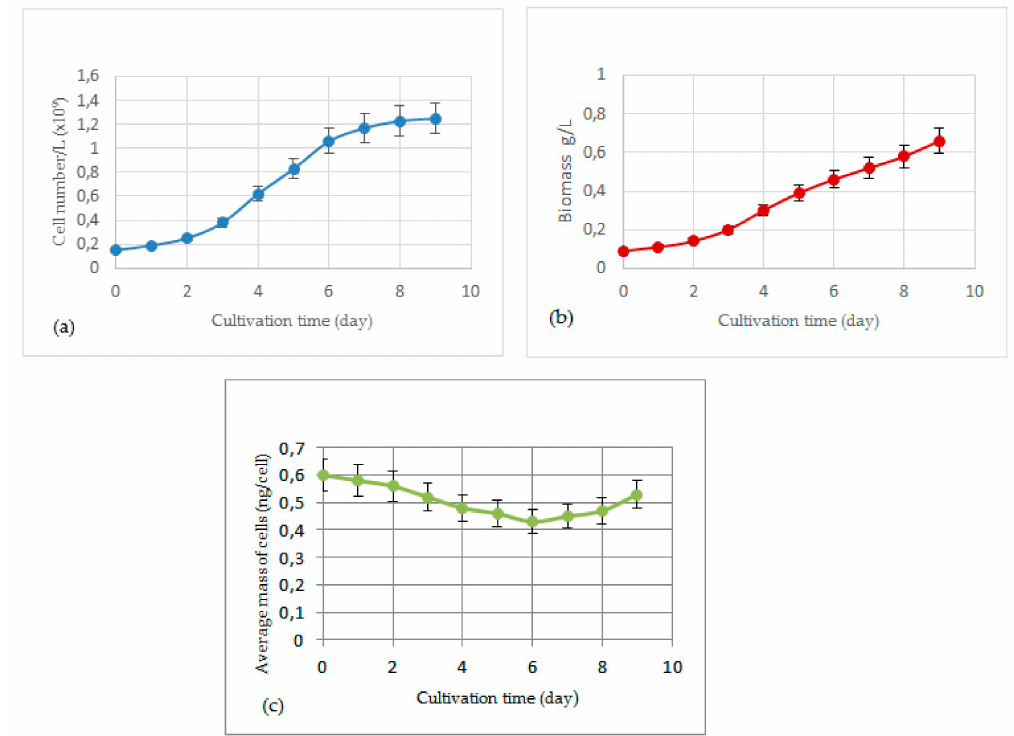
Figure 1. Growth of R. subcapitata immobilized in alginate beads over a period of 10 days (culture performed in batch and in duplicate): ( a ) variations in the number of cells; ( b ) variations in biomass; ( c ) variations of the average mass of cells. t 0 = d 1